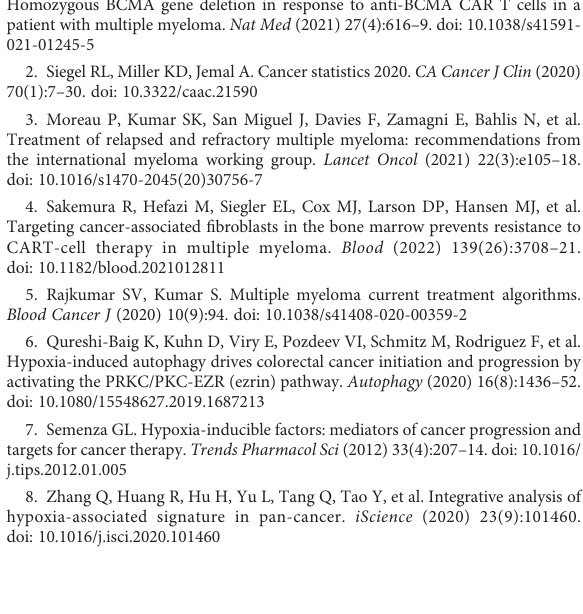
SUPPLEMENTARY FIGURE 1 GSE136337 validation cohort. (A) The K-M survival analysis between the high- and low-risk groups. (B) The ROC curve at 1, 3 and 5 year of prognostic value of the prognostic index. (C – E) Risk score, survival time and distribution of signature genes expression pattern between the two